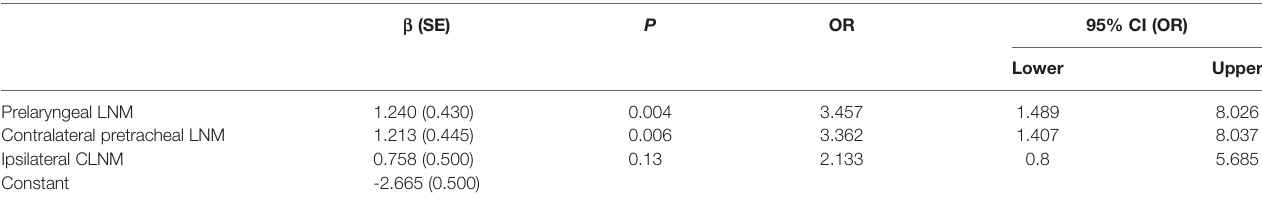
TABLE 4 | Multivariate analysis of risk factors for contralateral